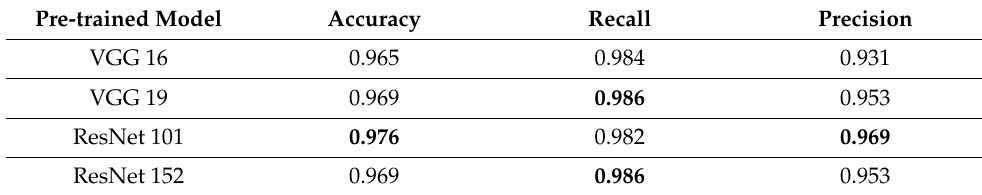
Table 4. Performance using k -nearest neighbor.